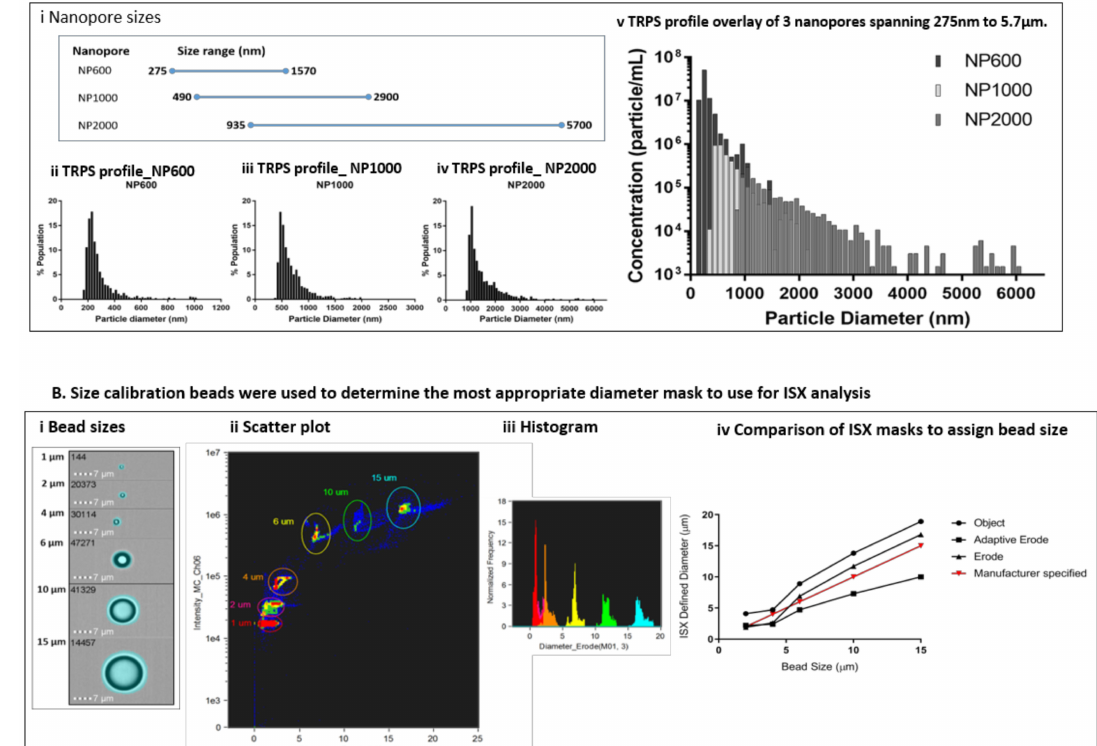
Figure 3. EV size and quantity was assessed by Tunable Resistance Pulse Sensing (TRPS) using the qNANO instrument (iZON Science) and compared to diameter masks in the ISX IDEAS software. ( A ) Three Nanopores of over-lapping size ranges were used to determine the particle diameter and concentration in each EV preparation (i). Size profiles were established for each individual Nanopore (ii NP600; iii NP1000; iv NP2000). The overlaid profiles of diameter by concentration provided by the 3 Nanopores show a size range of 250 nm and 6 µ m against a common calibrator bead of 1000 nm (representative sample shown) (v). ( B ) Calibration beads of known size were used to determine the most accurate diameter mask. The masks available within the ISX IDEAS software for diameter analysis were compared. The 3 which assigned the most accurate sizes according to manufacturer specified beads sizes were the Object, Erode and Adaptive Erode masks. These were compared across bead size by applying the mask (ii) visualising a scatter plot (iii) and histogram for each mask type. For the size range within our EV preparations, we found the Erode mask to be the most accurate